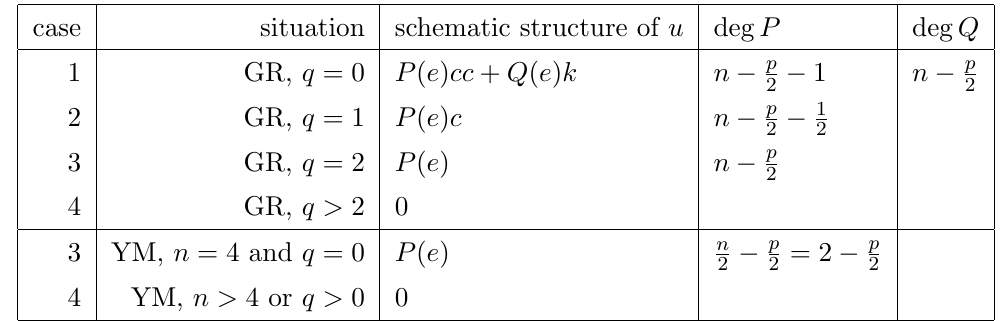
Table 1 . List of cases in the proof of lemma